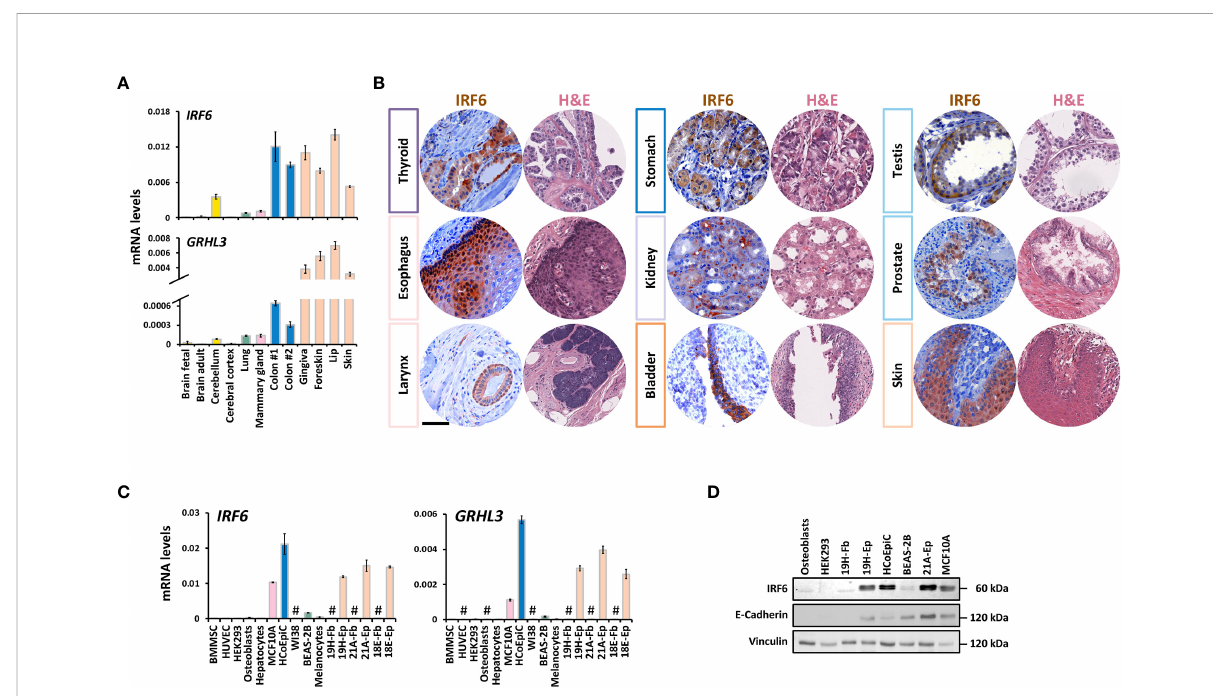
FIGURE 1 IRF6 and GRHL3 expression in healthy human adult tissues and cells (A) QPCR analysis of IRF6 and GRHL3 in a panel of healthy human adult tissues. Color code refers to tissue groups introduced in Supplementary Figure 1A. (B) IHC for IRF6 as well as a representative H&E staining of a set of normal human tissues. Note that IRF6 exhibits nuclear as well as cytoplasmic localization. Scale Bar: 50 µm. (C) QPCR analysis of IRF6 and GRHL3 in a panel of healthy human cell strains/lines. not detectable (cT > 32) (D) Immunoblot for the proteins IRF6 and E-Cadherin in a set of human cell strains/lines. Note the typical IRF6 double-band indicative of its phosphorylated and non-phosphorylated form, respectively. Full- length blots are shown in Supplementary Figure 6 kDa, kilo